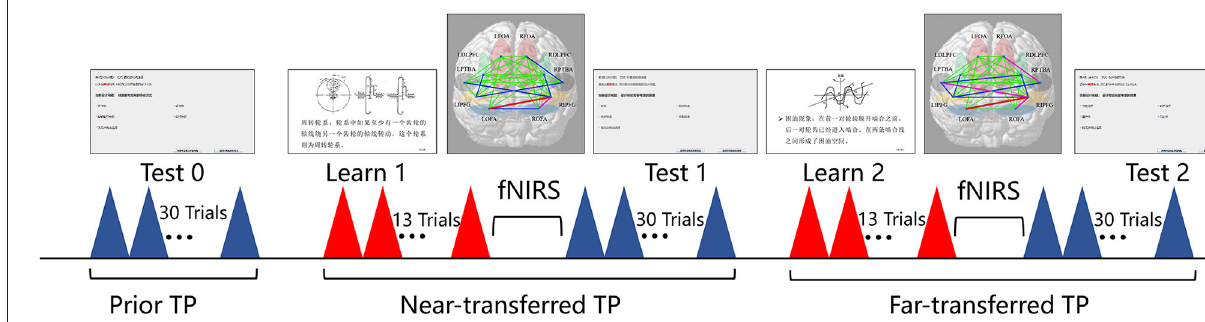
FIGURE 2 | Stimulus sequences and stimulus materials.